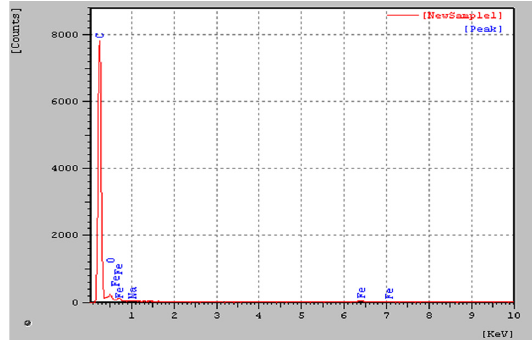
Figure 17. EDS analysis of TiC coated diamond in point 02 of Figure 15.